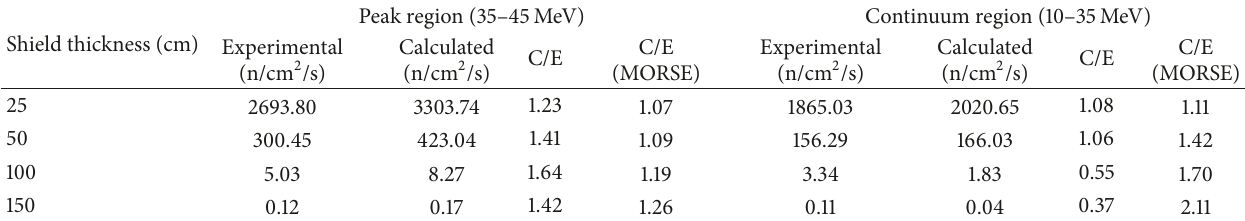
Table 1: The ratio of calculation to measurement in peak and continuum regions for concrete shielding experiments. Shield thickness (cm)